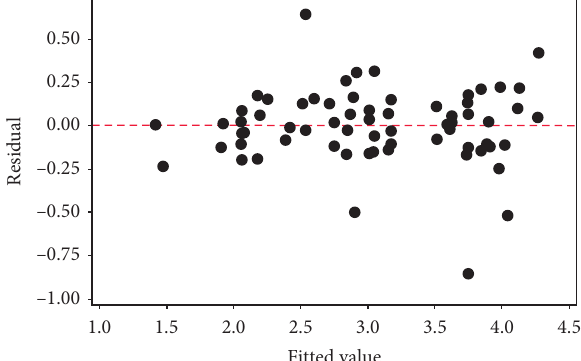
Figure 2: The residual diagram of residual versus actual values for validation of the best fitted model for Rhizophora mucronata